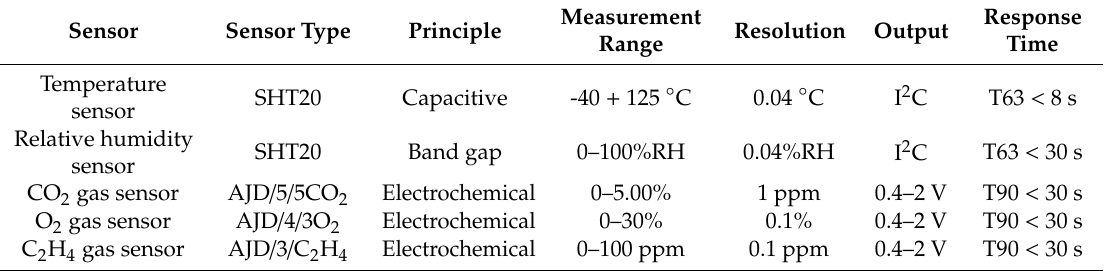
Figure 2. The hardware design of the multi-sensor monitoring detector. ( a ) The flow chart of the multi-sensor monitoring detector. ( b ) Hardware of multi-sensor monitoring detector. Table 1. The sensor list for monitoring in fragrant pear cold chain logistics.